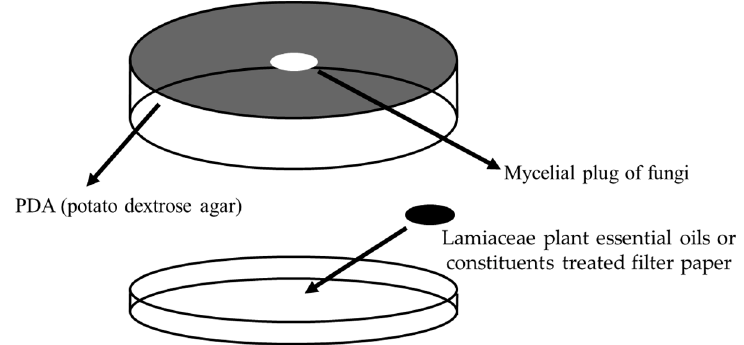
Figure 1. Fumigant antifungal activity test.